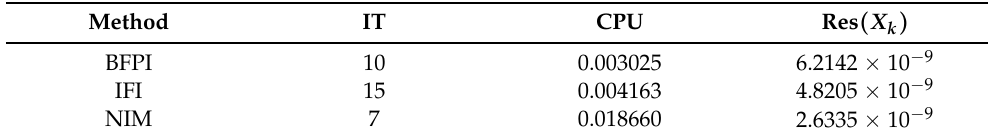
Table 1. The numerical results of Example